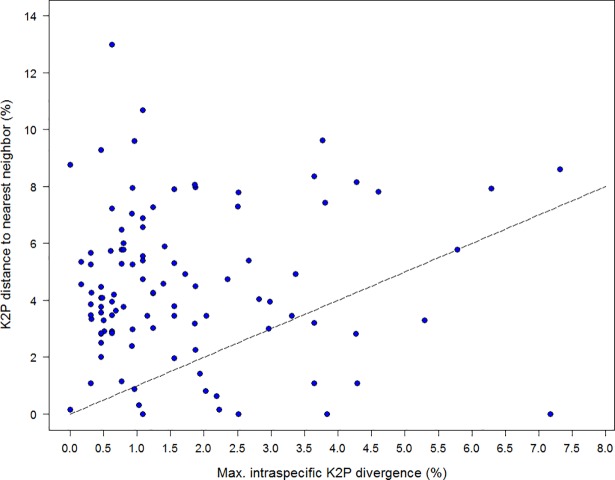
Maximum intraspecific sequence divergences for 102 Lepidoptera species in relation to nearest neighbor.Barcode sequence distances to the nearest neighbor species in relation to maximum intraspecific distances for 102 species of Palearctic Lepidoptera. The straight line indicates where distance to nearest neighbor equals the respective intraspecific distance, viz. for species above this line the ‘barcode gap’ does exist.